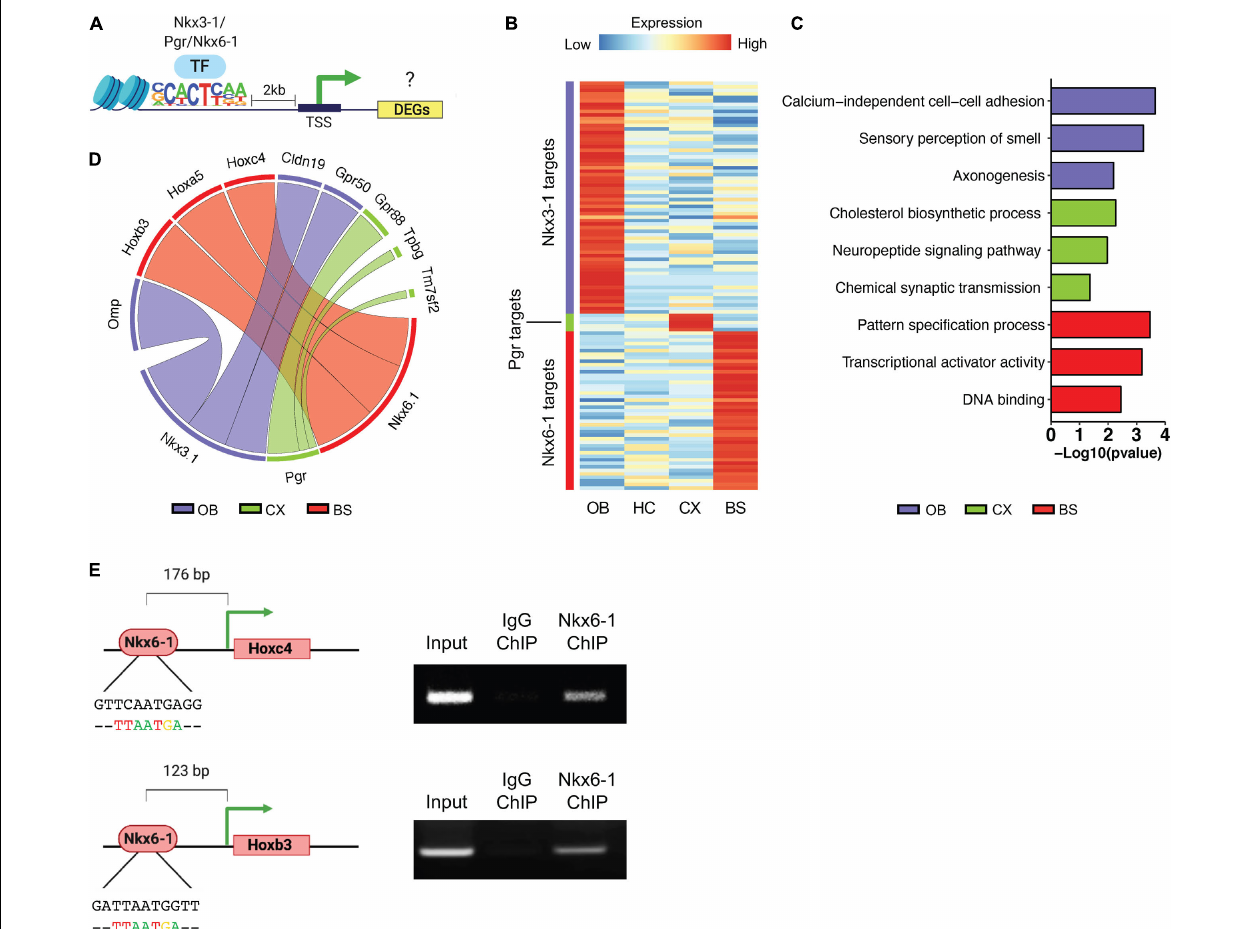
FIGURE 6 | Transcriptional regulatory network profiling. (A) Schematic of methodology for predicting transcription factor targets. (B) Heatmap showing log2 transformed expression of potential transcription factor targets. (C) Gene ontology analysis of predicted targets. (D) Circos plot to visualize top predicted targets by transcription factor, line width represents fold change. (E) ChIP-PCR Schematic and ChIP-PCR result of Nkx6-1 binding at Hoxc4 and Hoxb3 promoters in the brainstem.